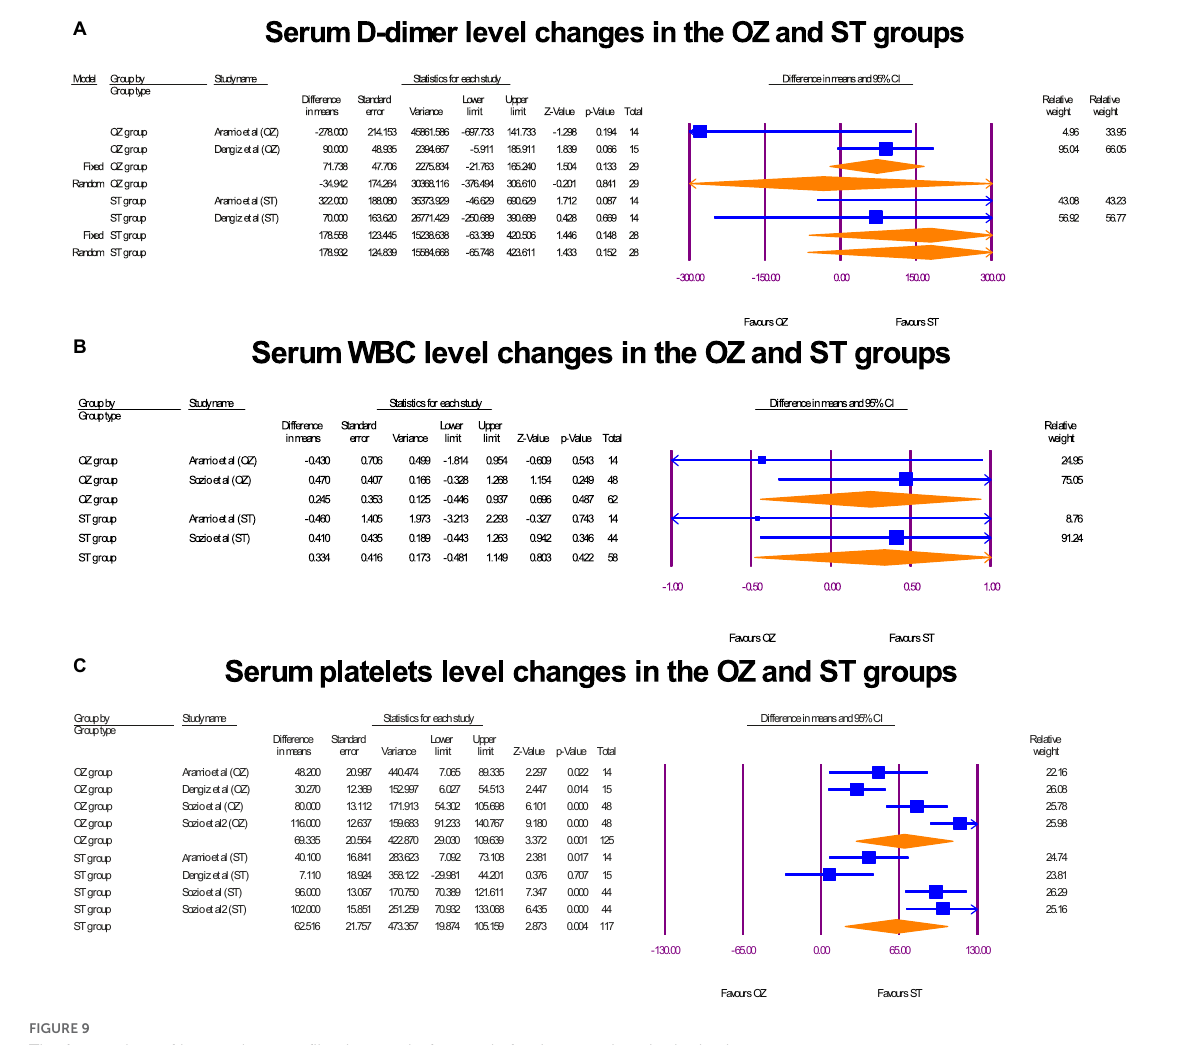
FIGURE9 The forest plots of hematology profile changes before and after interventions in the both